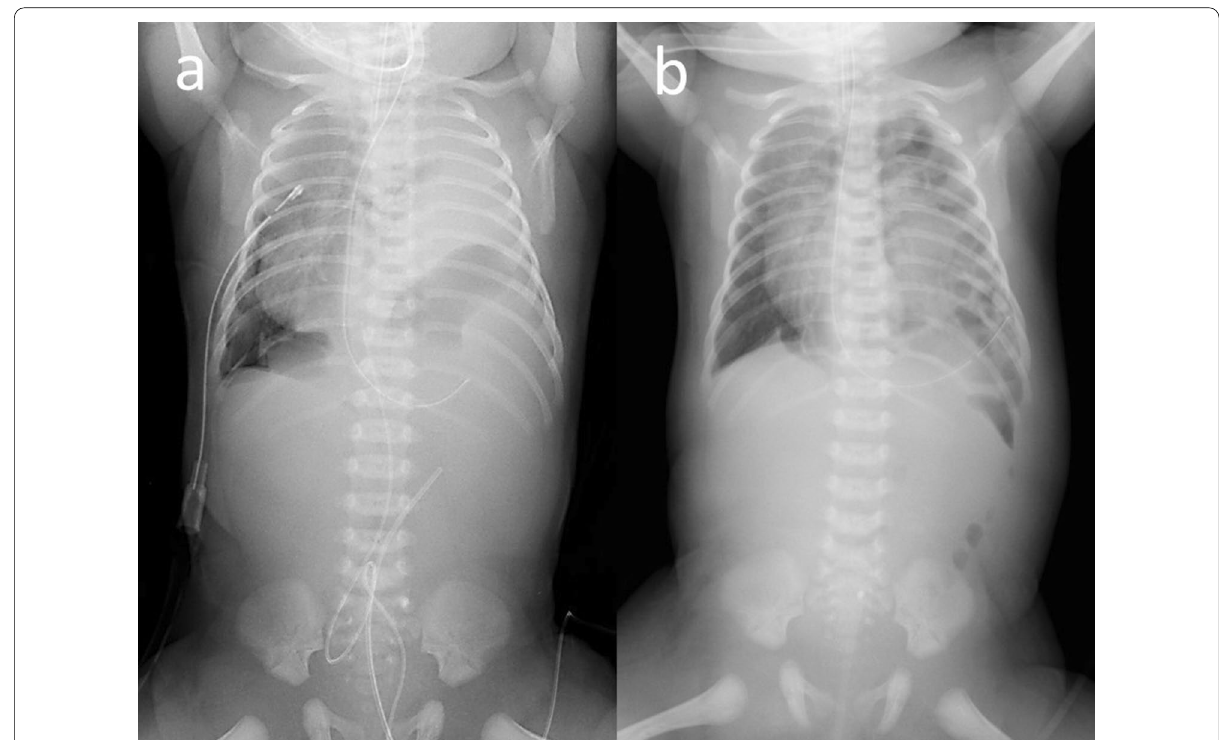
Fig. 1 Abdominal and chest X-ray on admission ( a ) and day 4 ( b ). a Nitric oxide was inhaled and ventilator support was provided. A right pneumothorax was noted and required intrathoracic drainage until day 3. b The stomach, spleen, and small and large intestine were elevated in the thoracic